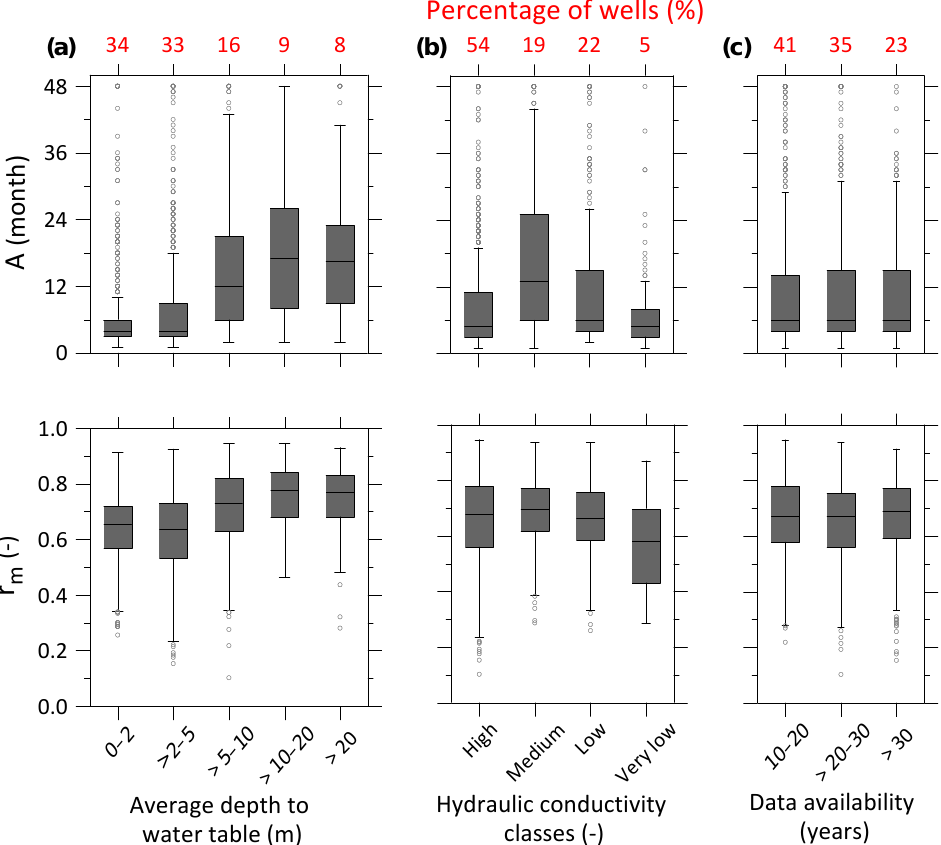
Figure 3. Box-and-whisker plots of the optimal accumulation period A (top) and the maximum correlation r m (bottom) estimated for a group of wells with varying depth to water tables (left: a ), aquifer hydraulic conductivity classes (middle: b ), and record lengths (right: c ). Results shown for the aquifer hydraulic conductivity corresponding to the German wells are grouped into four distinct classes: high ( > 10 − 3 ms − 1 ), medium (10 − 3 –10 − 5 ms − 1 ), low (10 − 5 –10 − 7 ms − 1 ), and very low ( < 10 − 7 ms − 1 ). The percentage of wells falling within each group is indicated at the top of every